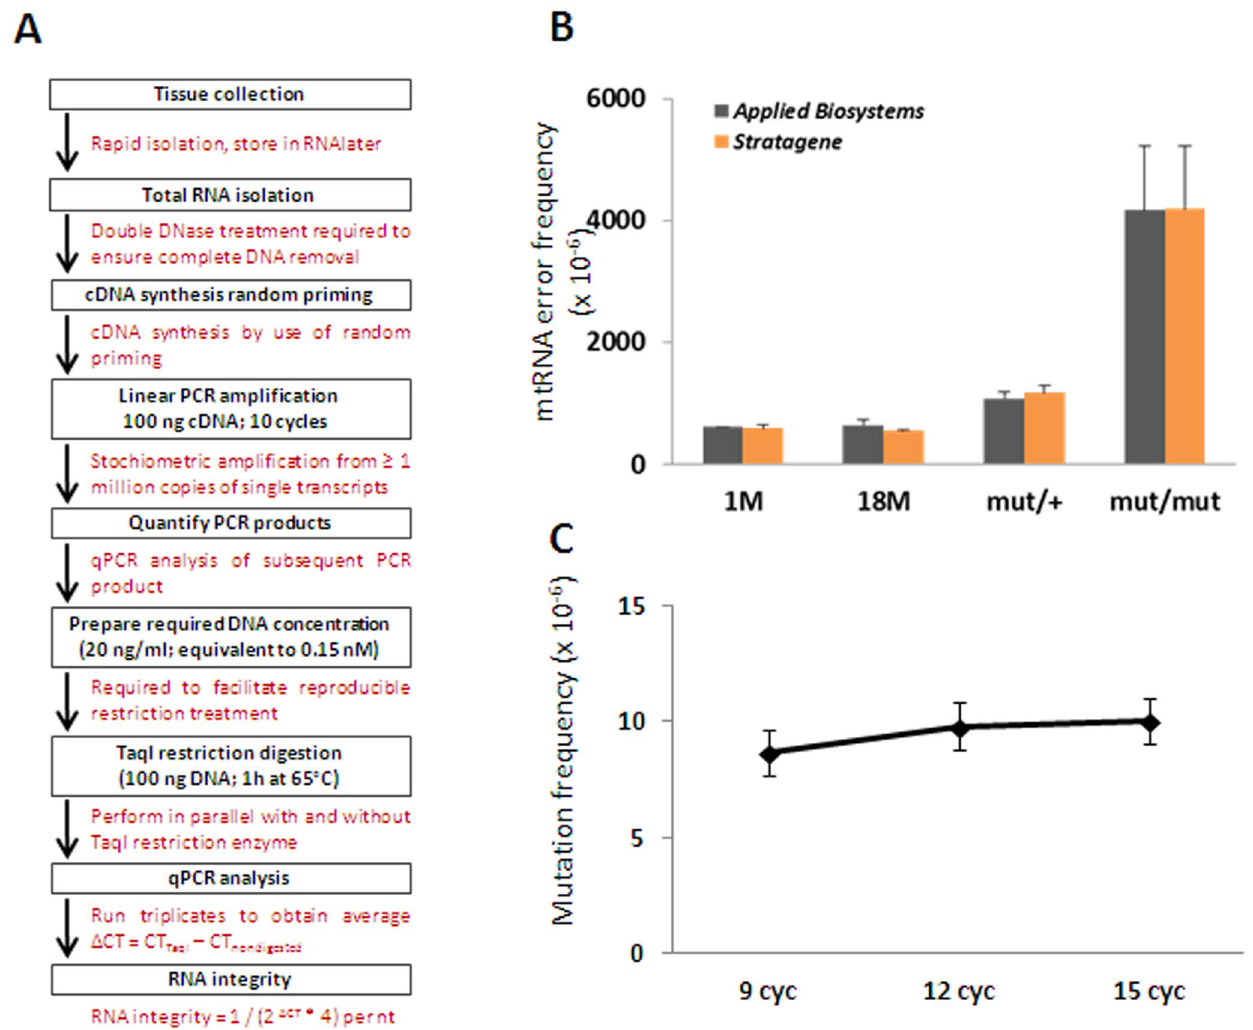
Figure 2. Validation of Method. (A) Flow chart illustrating the procedure for detection of mtRNA integrity. (B) Comparison of RNA integrity in CoxI site obtained by using two different commercially available reverse transcriptases. (C) Estimation of errors introduced in the PCR amplication. The 12S rRNA region was amplified with increasing cycle number and 100 ng PCR product was either digested with TaqI or left untreated and subsequently analyzed for mutations. The mutation frequency is plotted as function of PCR cycle number. The figures show mean with SD from three independent experiments.